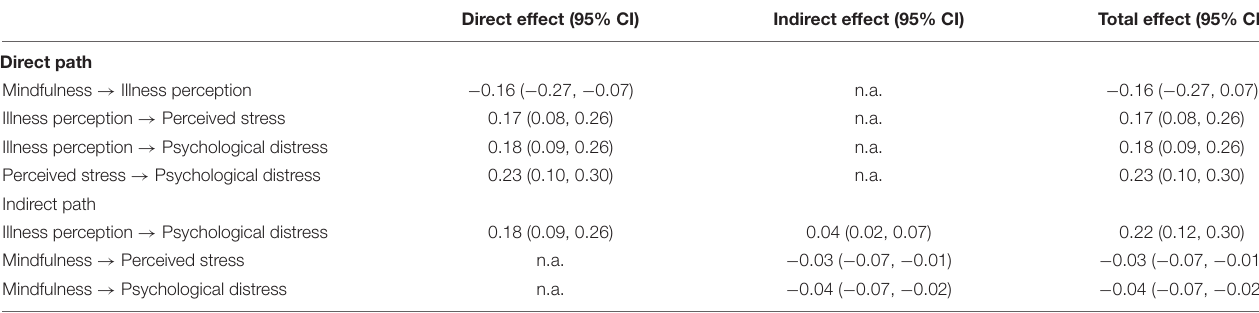
FIGURE 1 | Mechanisms of mindfulness on psychological distress among Chinese patients with lung cancer. Theoretical mechanisms of mindfulness on psychological distress according to correlation analysis (A) , influencing of mindfulness on psychological distress through illness perception (B) , and influencing of psychological distress on psychological distress through the chain mediating role of illness perception and perceived stress (C) . ∗ P < 0.05, ∗∗ P < 0.01. TABLE 3 | Effect estimates of mindfulness to psychological distress through illness perception and perceived